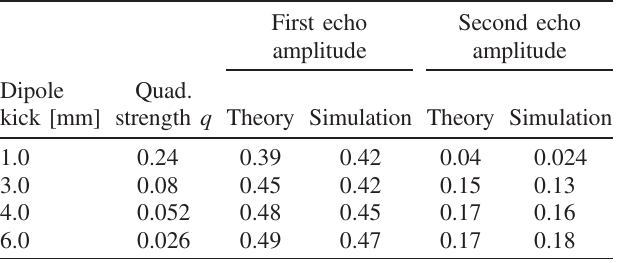
TABLE II. Maximum relative amplitudes of the first and second echoes from theory and simulations. The emittance is constant at ε 0 ¼ 9 . 7 × 10 − 8 m or rms size σ 0 ¼ 1 mm. For each dipole kick, the quadrupole strength is chosen from simulations that maximizes the first echo amplitude.